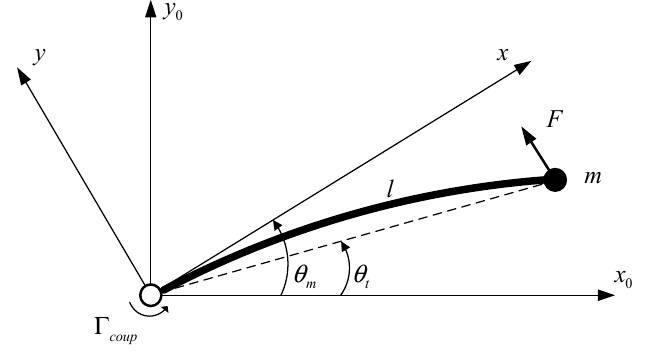
Figure 1. Diagram of a single-link flexible arm.